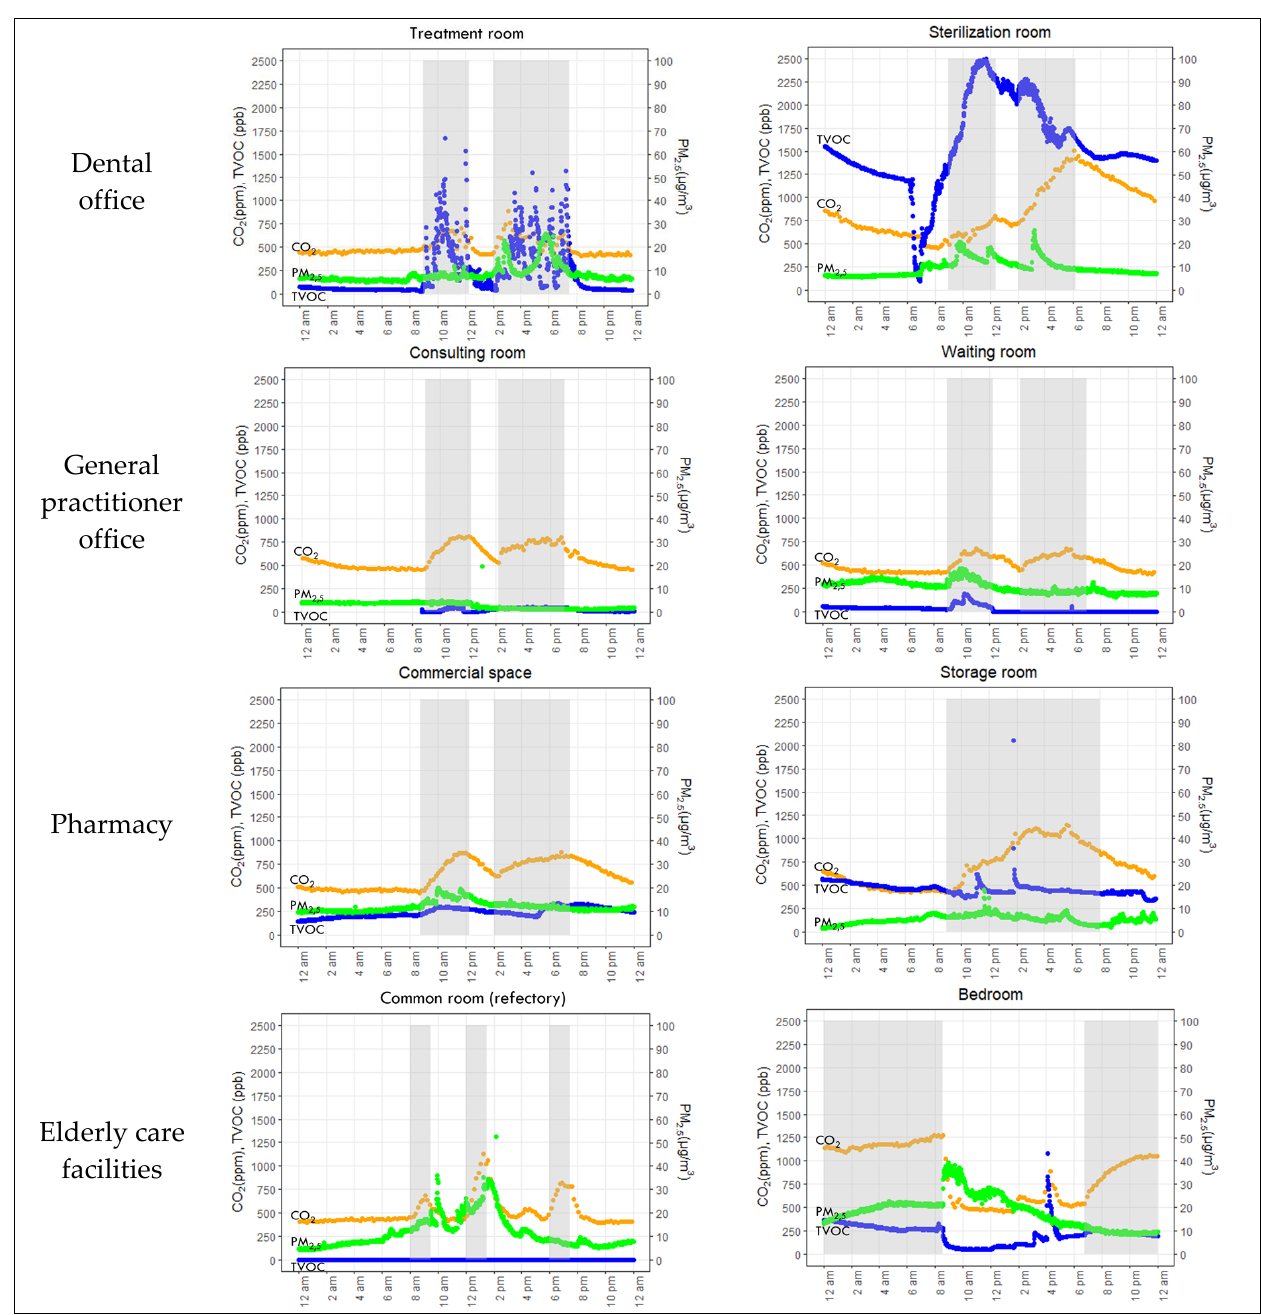
Figure 2. Continuous measurements of CO 2 (orange), TVOCs (blue) and PM 2.5 (green) concentrations for 24 h during the summer in different rooms of private healthcare and elderly care facilities. Notes: the shaded periods show the opening hours of healthcare facilities, mealtimes in the refectory and nocturnal time in the bedroom.